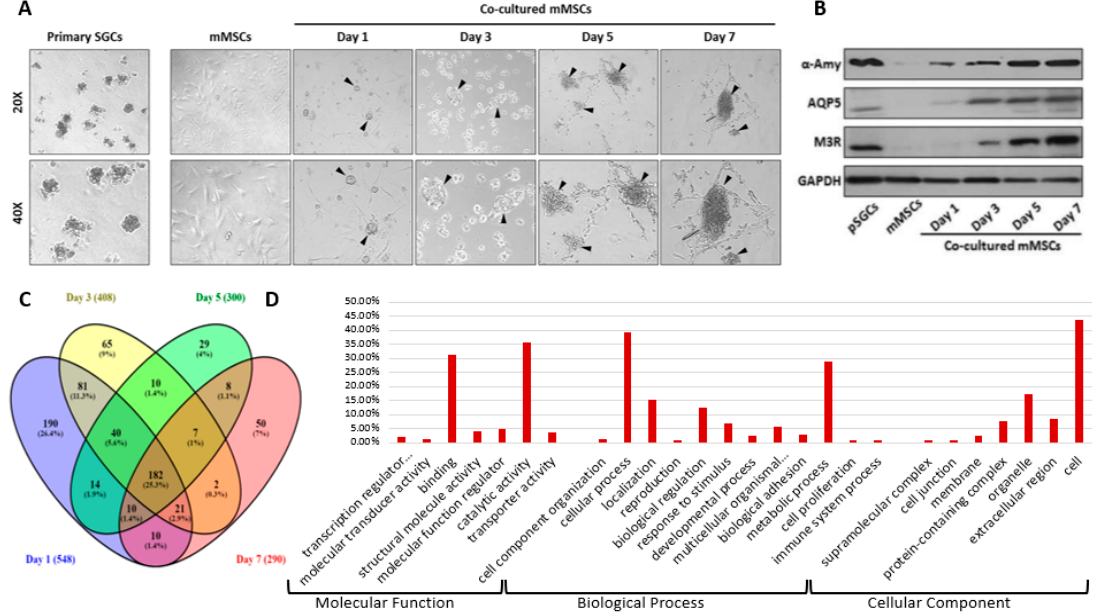
Figure 2. Morphological changes of mMSCs in the co-culture system and characterization of the secreted molecules detected in the conditioned media. ( A ) Microscopic images of pSGCs in the left panel and co-cultured mMSCSs in the right panels at days 1, 3, 5 and 7. All images are shown at a 20X (upper panel) and 40X (lower panel) magnification. Aggregated islets of mMSCs are present on day 1 of co-culture, resembling the islet-like appearance of pSGCs. ( B ) Salivary gland markers such as α -AMY, AQP5, and M3R were confirmed by western blotting. ( C ) A Venn diagram showing the number and percentage of secreted proteins detected at each collection time point. ( D ) A total of 548 secreted proteins on day 1 were assigned to 26 functional groups using Gene Ontology (GO). The three main categories consist of molecular function, biological process, and cellular component. The calculated percentages on the Y-axis were based on the proportion of the identified proteins in each gene set (GO: http: // geneontology.org / docs / go-enrichment-analysis / ). Figure 2A,B, reprinted from refs. [25,26],